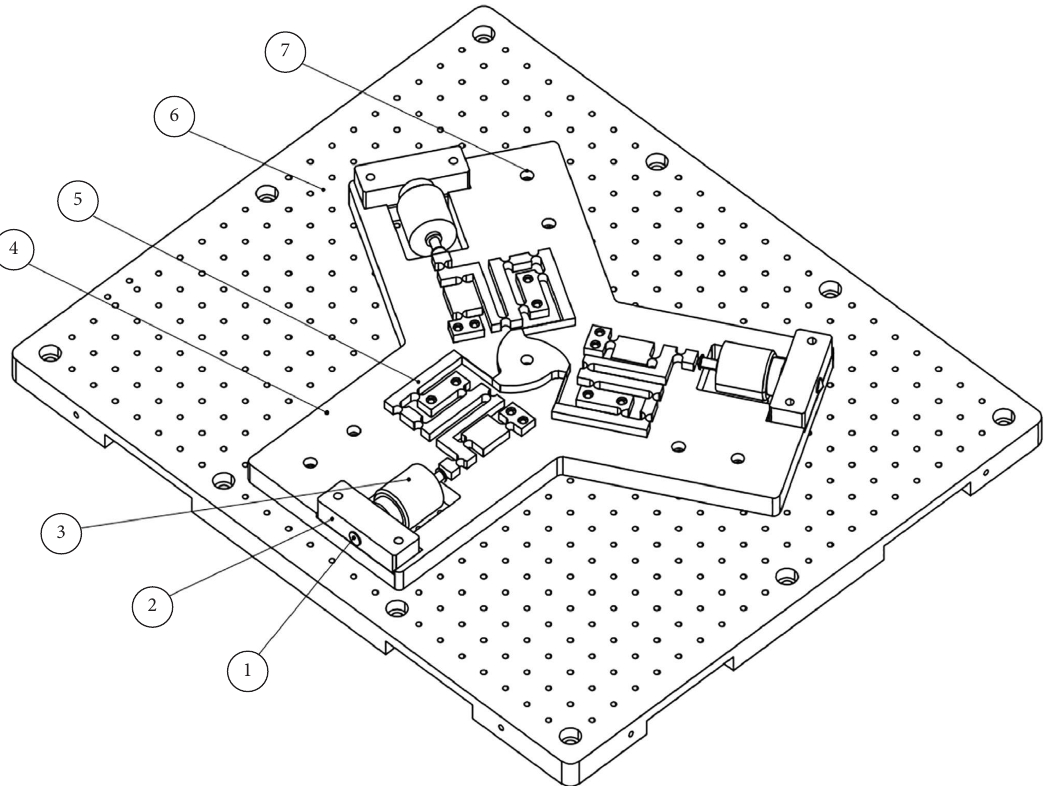
Figure 2: Assembly scheme of XYθ mobile positioning microrobotic platform: (1) preload crew, (2) PZTmounting plate, (3) PZTactuator, (4) intermediate plate, (5) prototype, (6) anti-vibration fxing plate, (7) fxed